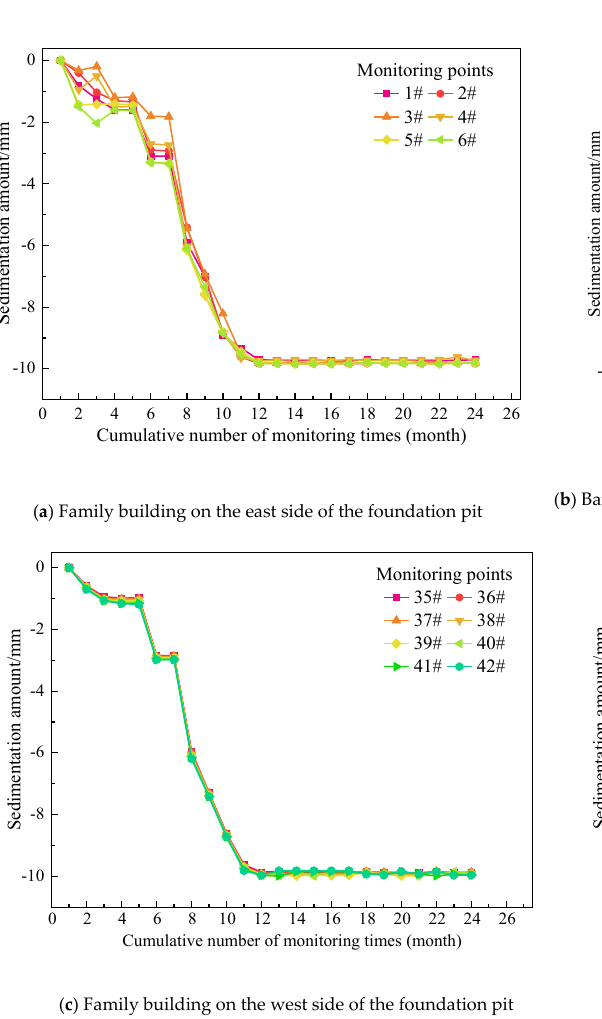
Figure 23. Curve of settlement of surrounding